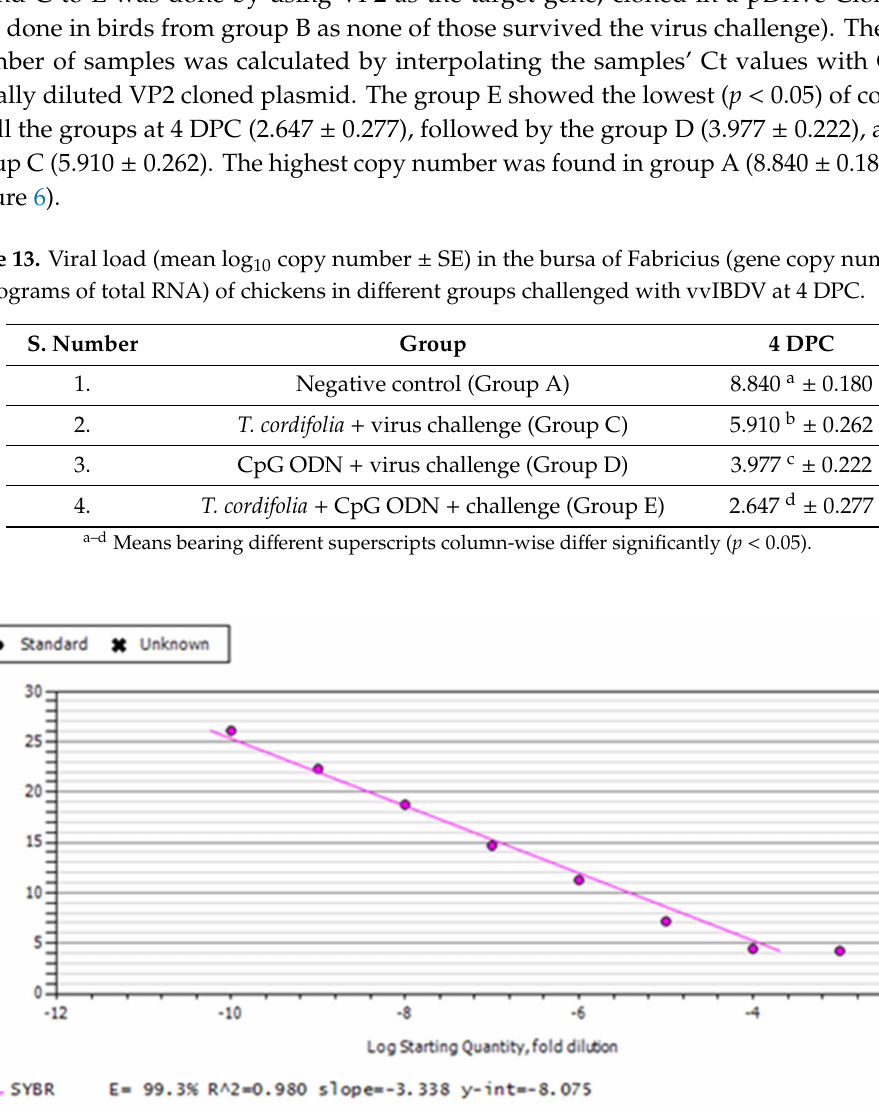
Figure 6. Standard curve with VP2 gene (189 bp) cloned in a pDrive cloning vector for viral load